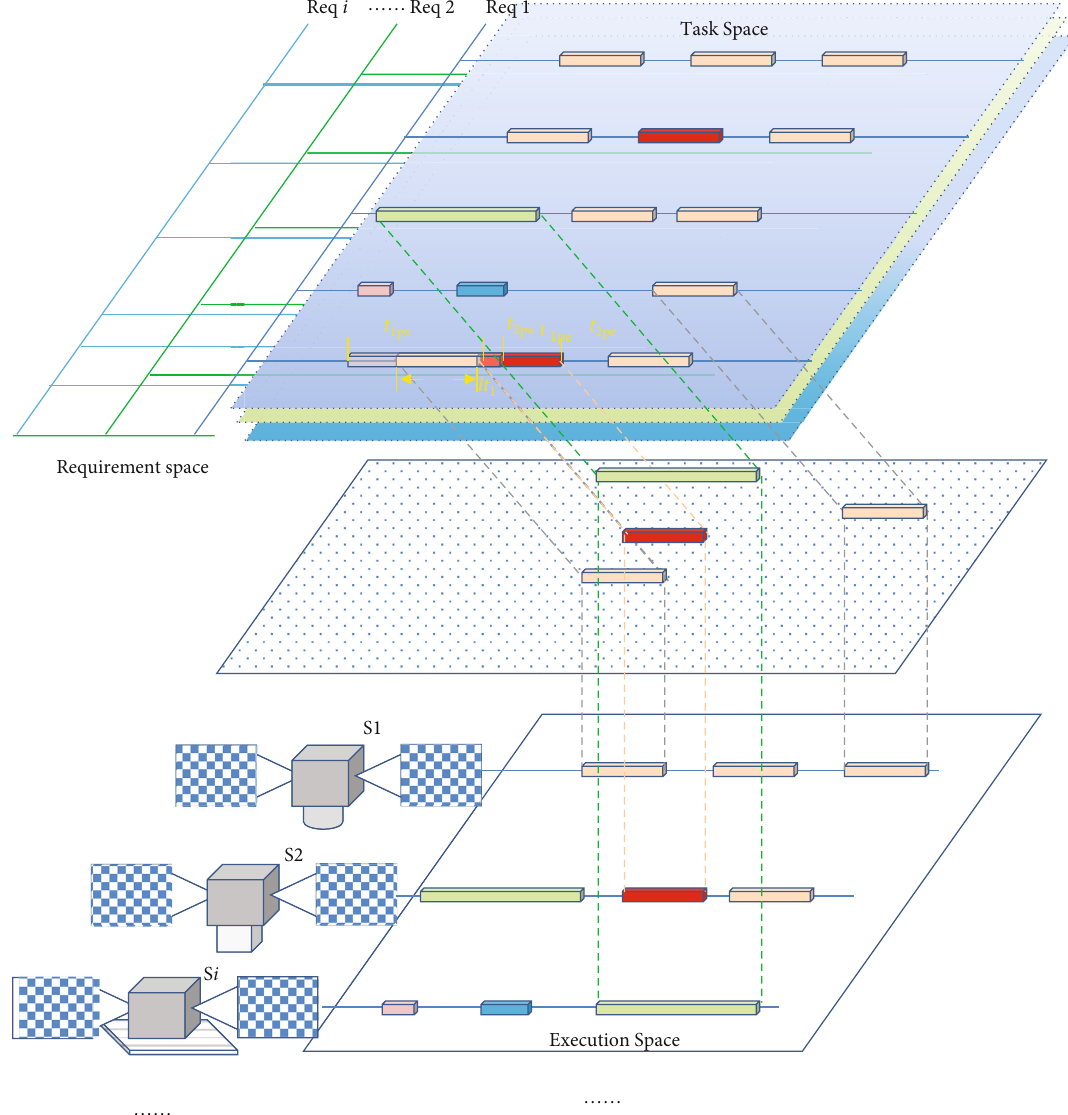
Figure 4: Swarm task allocation process model